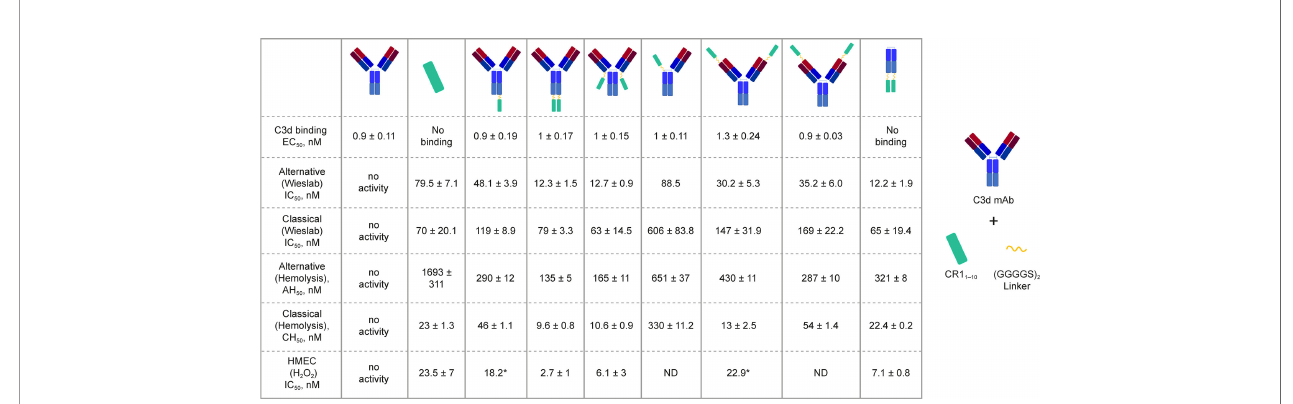
FIGURE 3 | C3d binding and complement inhibitory activity of test proteins. Binding af fi nity to C3d was evaluated by ELISA. In vitro functional potency of proteins was assessed using three complement activity assays: the Wieslab AP and CP complement assays, the AP and CP red blood cell (RBC) lysis assays, and the HMEC assay with H 2 O 2 induced injury. Schematics at the top of each data column indicate the orientation of the CR1 1-10 effector molecule (cyan rectangle). Where only a single dataset was collected, the value is denoted with “ * ”